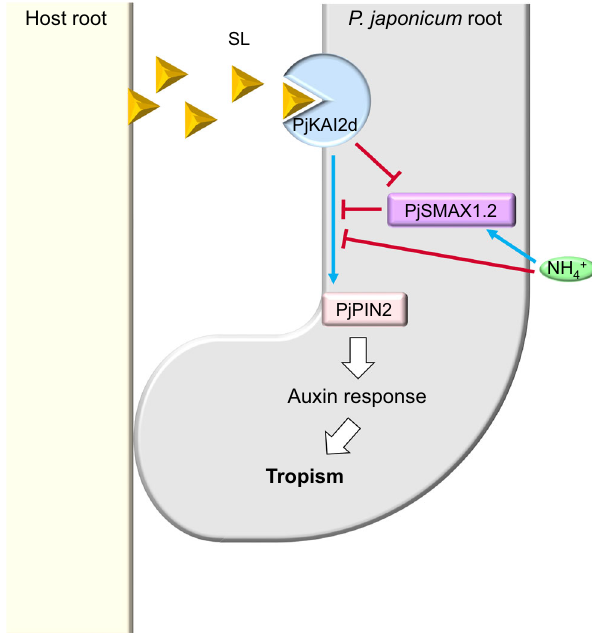
Fig. 5 | A schematic model of tropism to host-derived SLs in P. japonicum . Coloured arrows and T bars depict positive and negative regulations,